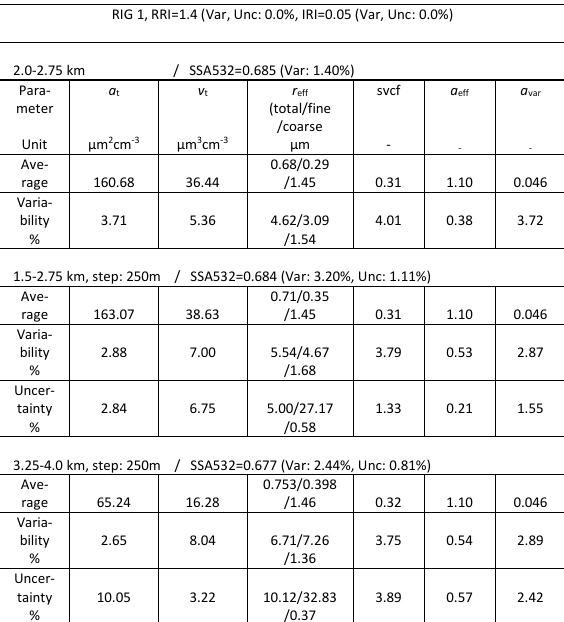
Table 2. Retrieved microphysical